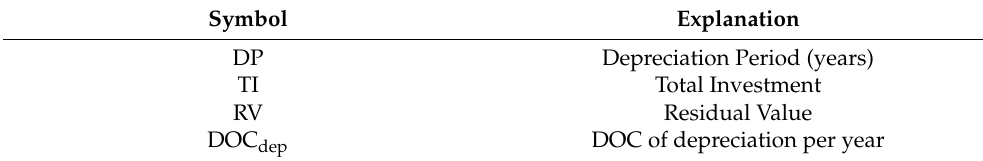
Table 1. Depreciation symbols